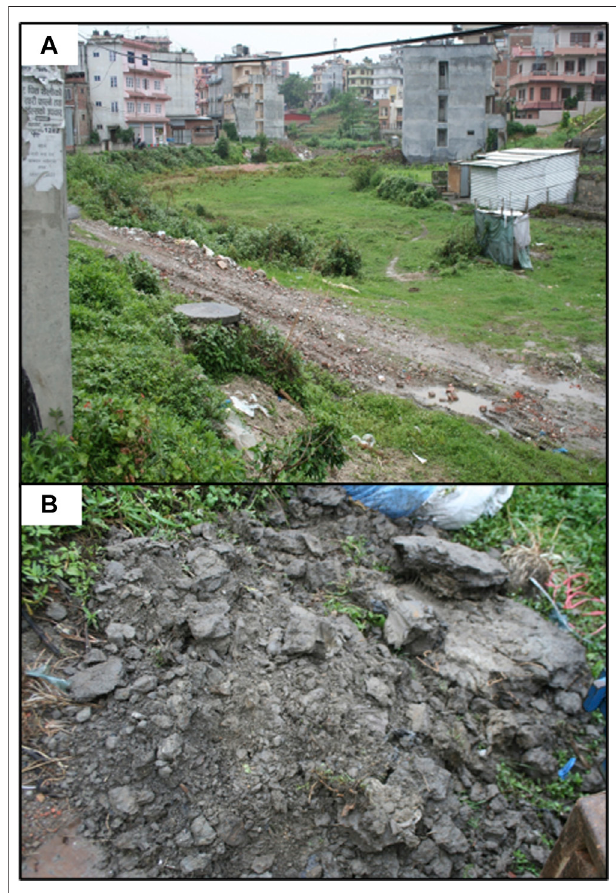
FIGURE 3 | (A) Site 03, Kausaltar looking southwest from adjacent to SCPT09 into the relic river channel. (B) Materials from hand pit adjacent to CPT09 [Photos: C. E. L.